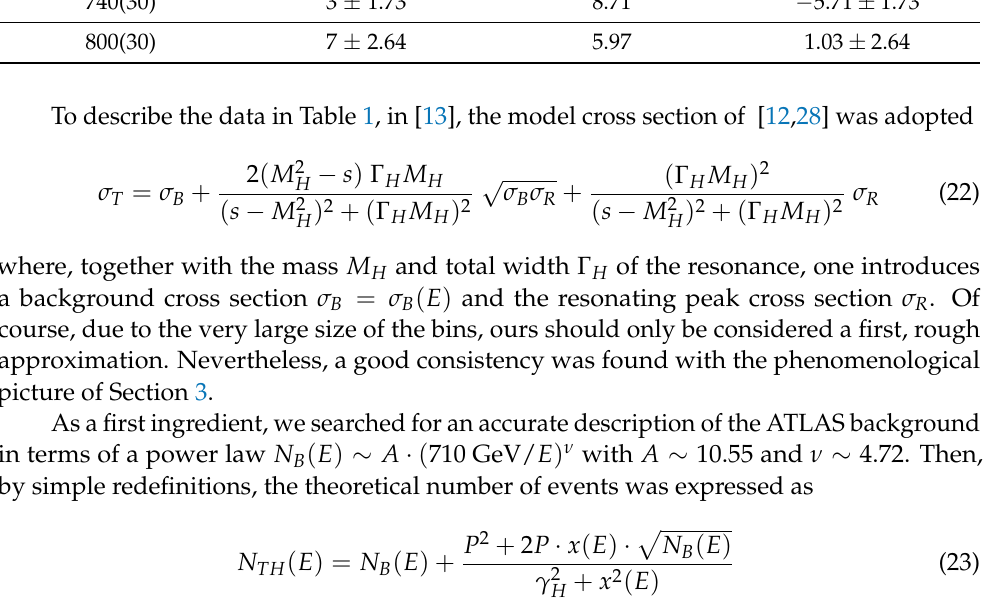
Table 1. For luminosity 139 fb − 1 , we report the observed ATLAS ggF-low events and the correspond- ing estimated background [29] in the range of invariant mass M 4 l = E = 530 ÷ 830 GeV. To avoid spurious fluctuations, due to migration of events between neighboring bins, we have followed the same criterion as in Figure 5 of [30] by grouping the data into larger bins of 60 GeV, centered at 560, 620, 680, 740, and 800 GeV. These were obtained by combining the corresponding 10 bins of 30 GeV, centered, respectively, at the neighboring pairs: 545(15) ÷ 575(15) GeV, 605(15) ÷ 635(15) GeV, 665(15) ÷ 695(15), 725(15) ÷ 755(15) GeV, and 785(15) ÷ 815(15) GeV as reported in [29]. In this energy range, the errors in the background are below 5% and will be neglected. E [GeV] N EXP ( E ) N B ( E ) N EXP ( E ) − N B ( E ) 560(30) 38 ± 6.16 32.0 6.00 ± 6.16 620(30) 25 ± 5.00 20.0 5.00 ± 5.00 680(30) 26 ± 5.10 13.04 12.96 ± 5.10 740(30) 3 ± 1.73 8.71 − 5.71 ± 1.73 800(30) 7 ± 2.64 5.97 1.03 ±